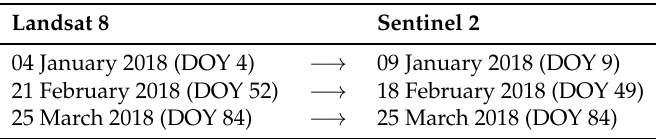
Table 3. Image dates used to fit the harmonization between L 8 and S